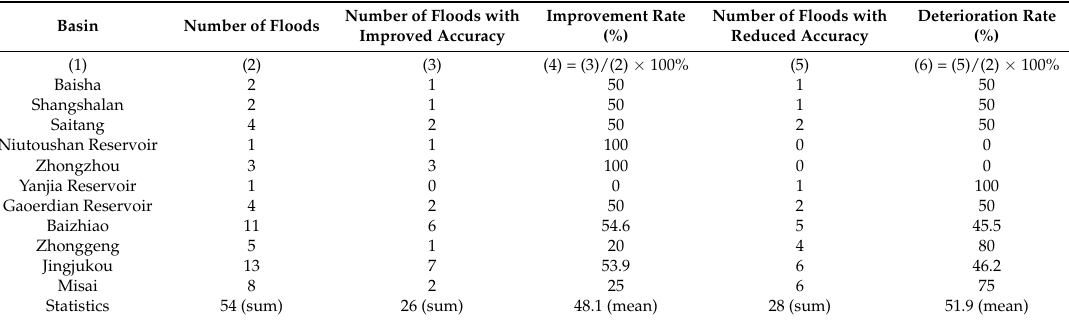
Table 15. Statistics of correction results of over-estimated floods in each basin.